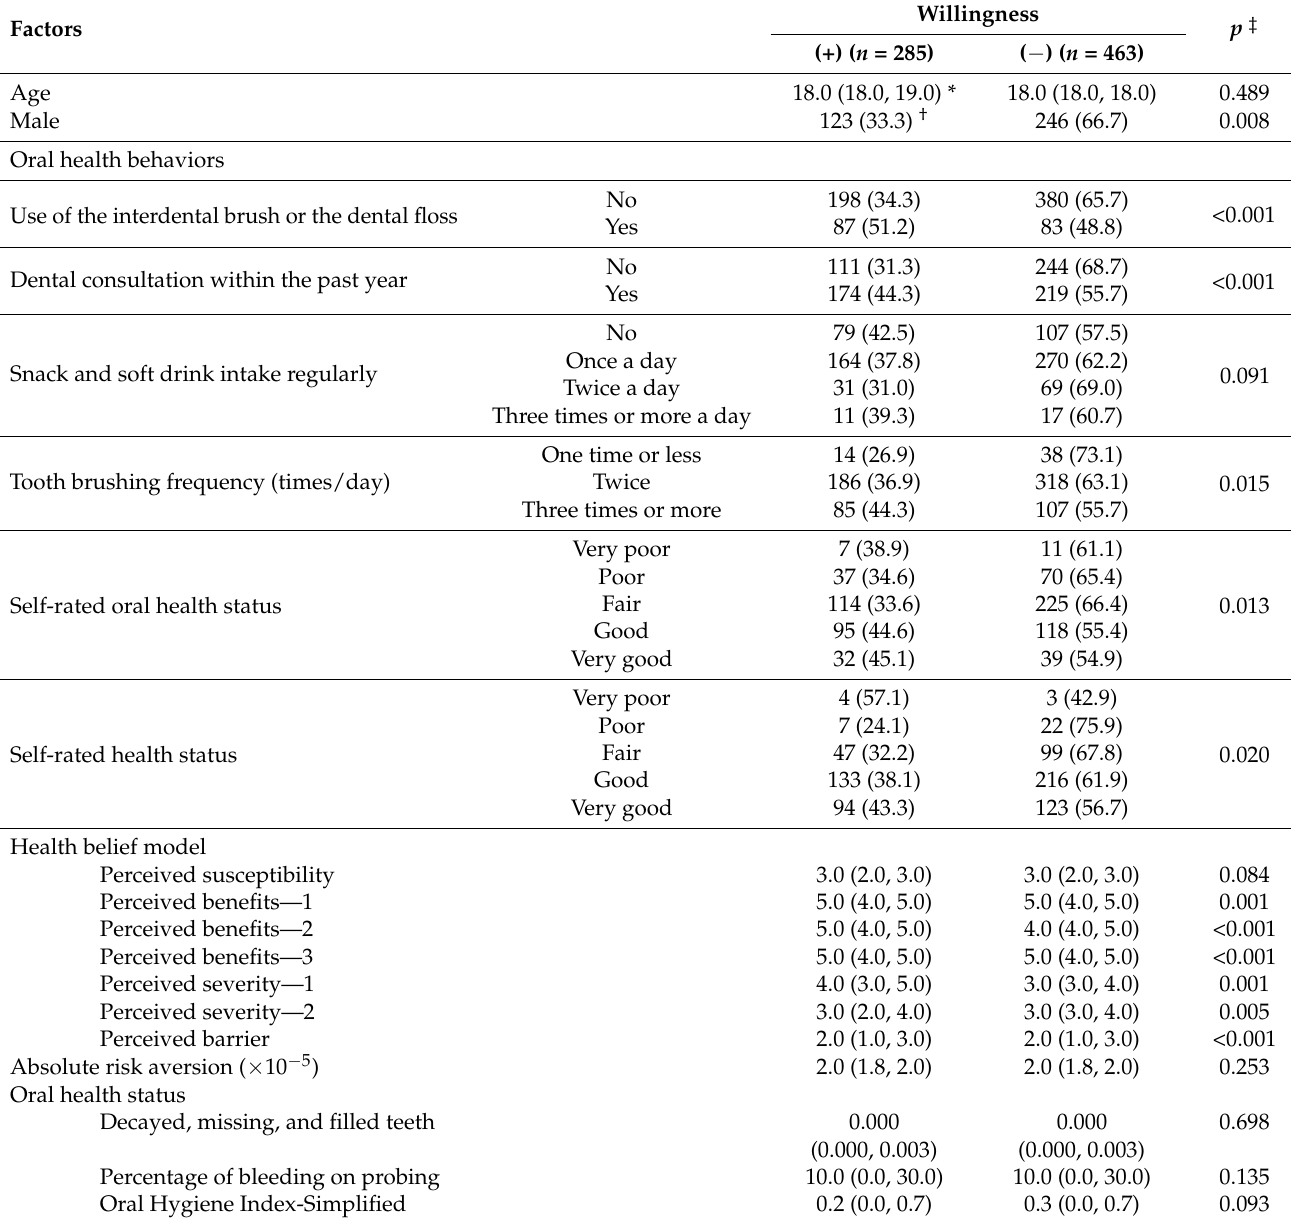
Table 1. Associations between willingness for regular dental check-ups and related